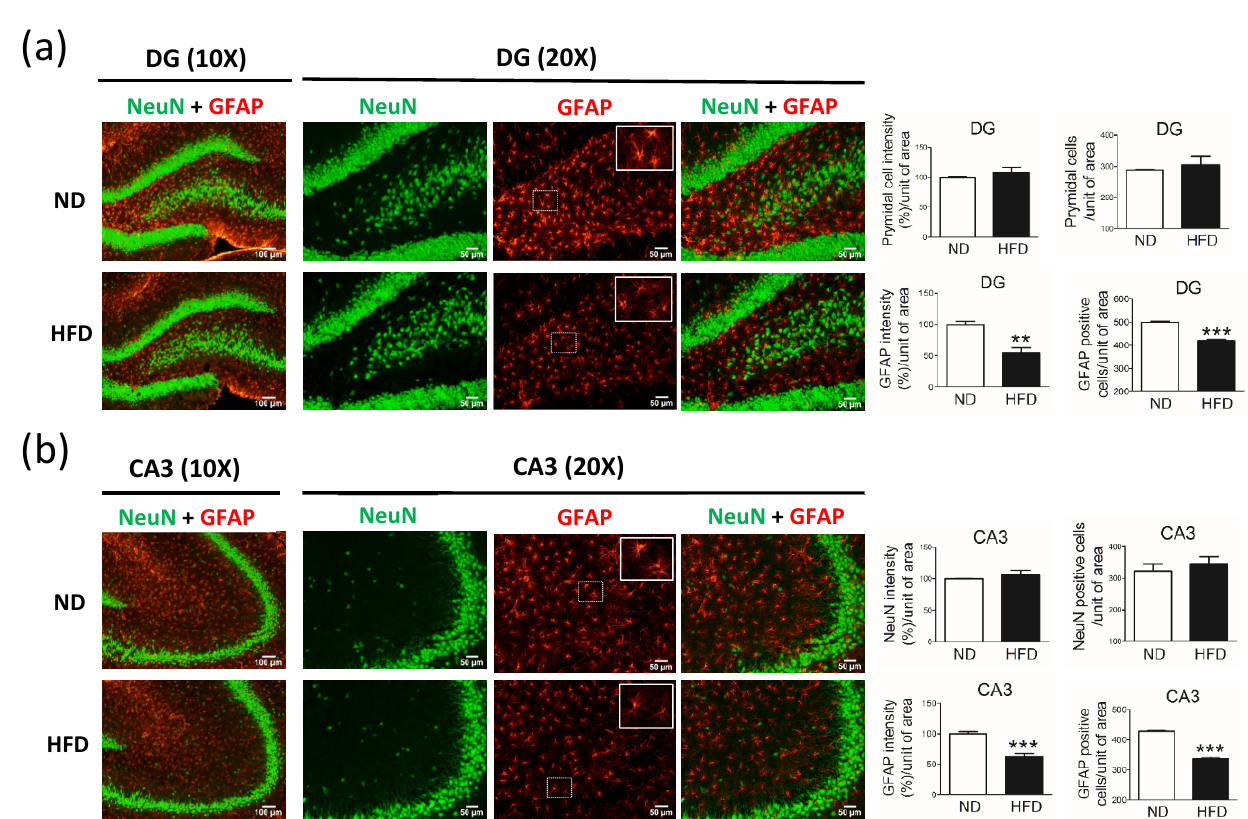
Figure 7. Immunostaining of pyramidal neurons (NeuN-positive cells) and astrocytes (GFAP-positive cells) in the hippocampus after middle-aged rats were fed a normal diet (ND; control, n = 4) or 45% high-fat diet (HFD; n = 4) for 30 weeks. Data were captured with 10X (scale bar = 100 µ m) and 20X (scale bar = 50 µ m) objectives. Immunostaining for NeuN (pyramidal neurons) and GFAP (astrocytes) in the ( a ) hippocampus dentate gyrus (DG) and ( b ) CA3. NeuN or GFAP immuno-intensity (%) and NeuN- or GFAP-positive cells per unit of area (20X objective) were quantified by using cellSens Dimension software (Olympus). Data are expressed as the mean ± SEM. ** p < 0.01, *** p < 0.001 between groups ( t -test).